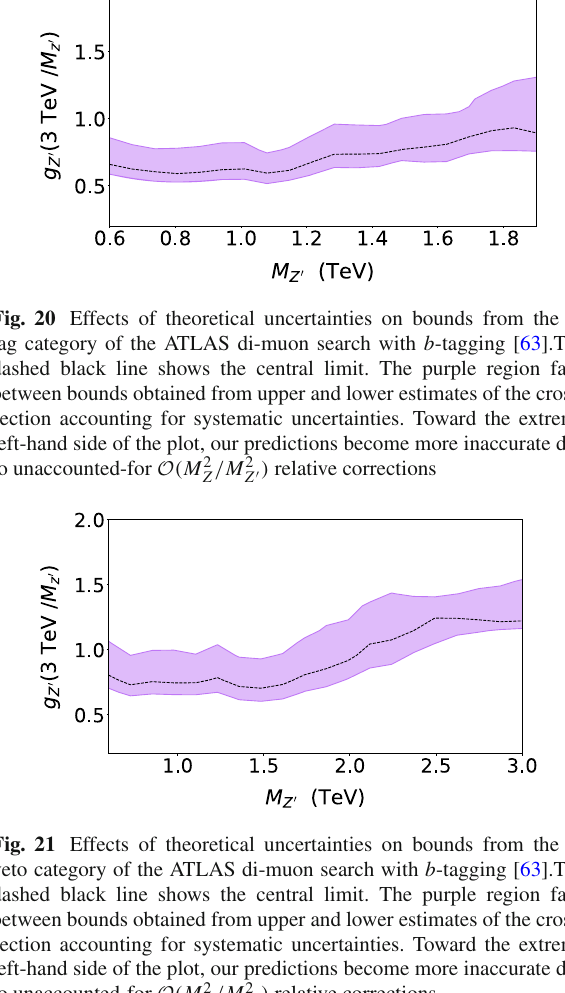
/ M 2 ) relative correc- Z Z (cid:2)